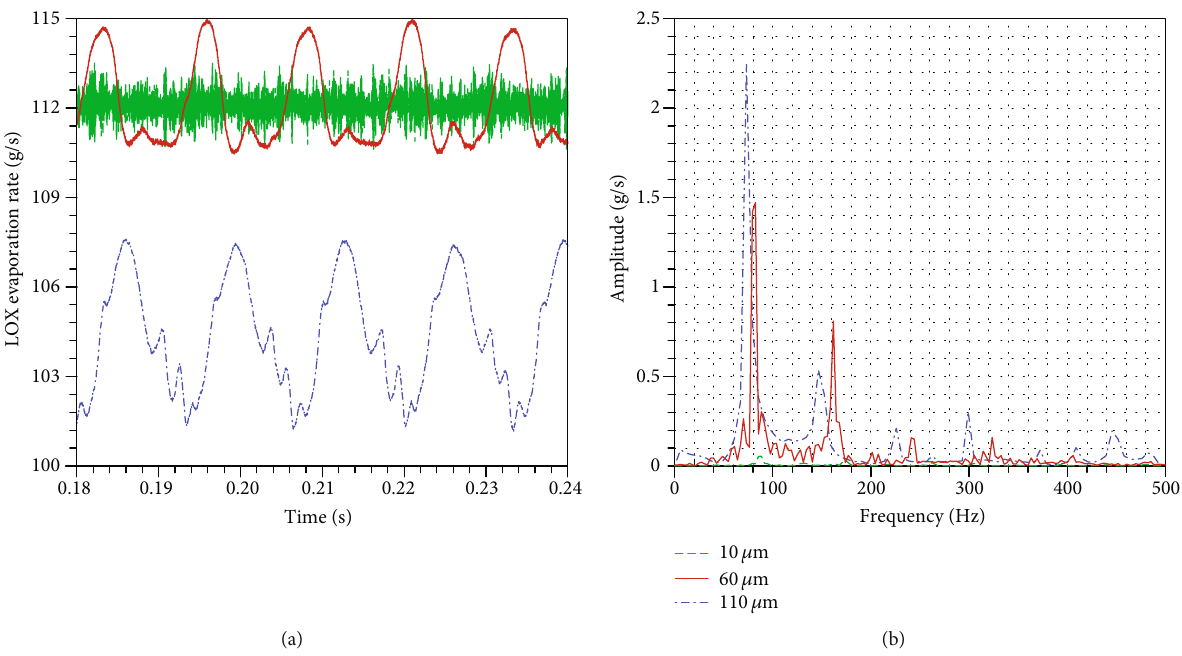
Figure 17: Time histories (a) of the LOX evaporation rate oscillations and the corresponding spectrograms (b) for di ff erent initial LOX particle diameters.